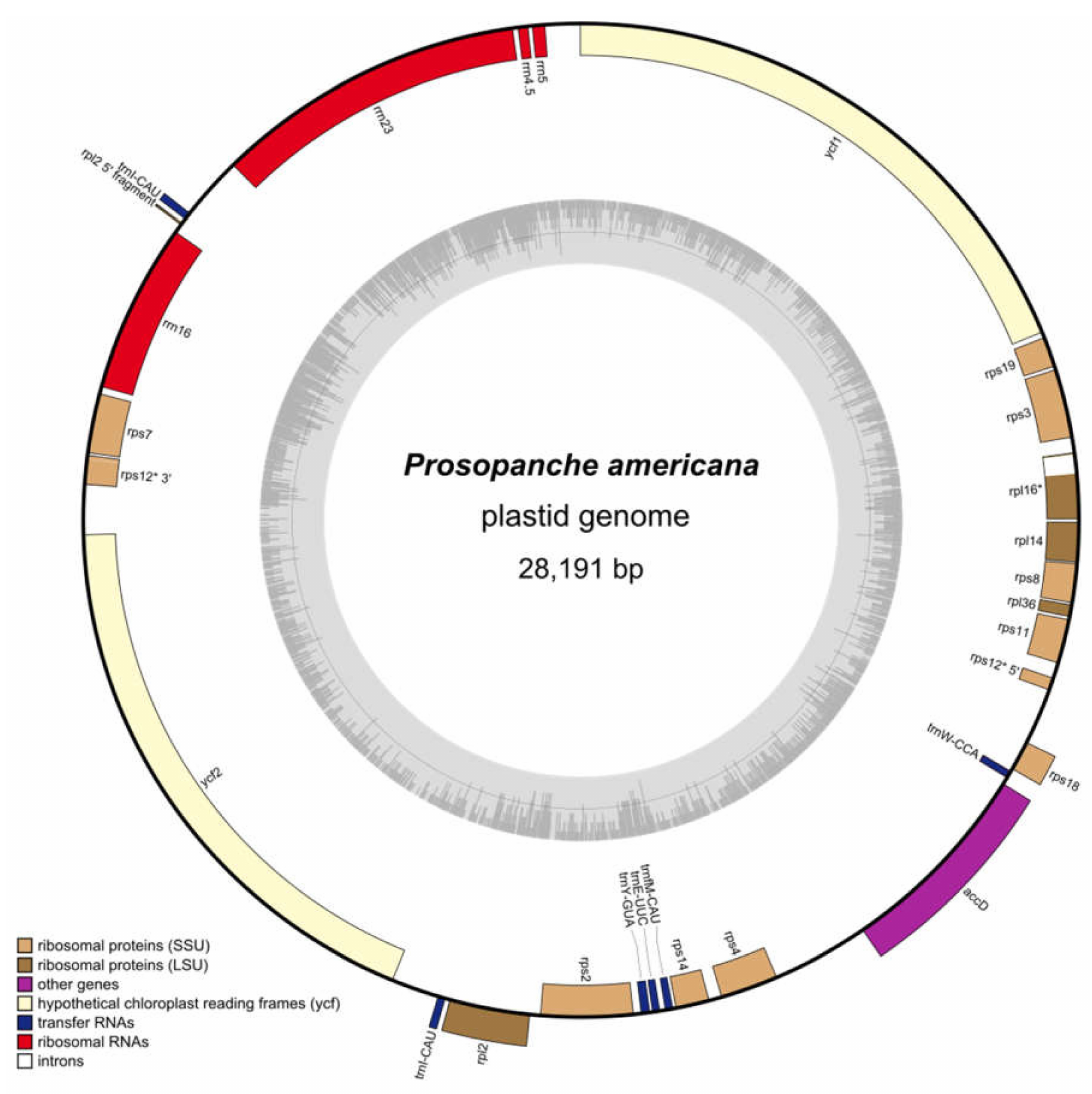
Figure 2. The highly reduced plastome of Prosopanche americana . The circular plastome of holoparasitic Prosopanche americana contains 24 unique genes (14 ribosomal protein genes, 4 ribosomal RNA genes, five genes coding for transfer RNAs and three genes with other or unknown function), which are distributed over a total length of 28,191 bp. Gene distribution is displayed on the outer circle with color coded gene groups according to the legend (bottom left). GC content is visualized as inner, grey circle. * indicates genes with